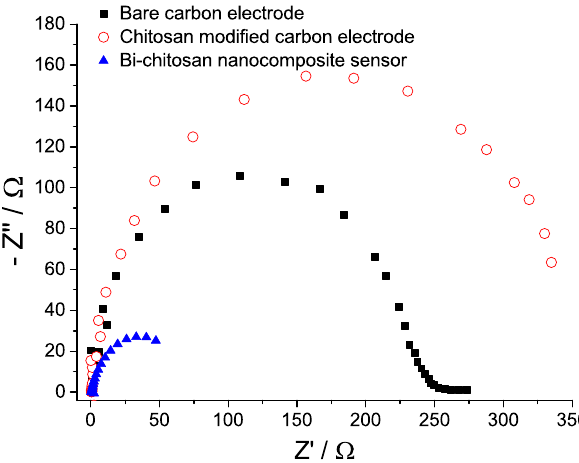
Figure 4. Nyquist diagrams of a bare carbon electrode, a chitosan modified carbon electrode, and a Bi-chitosan nanocomposite sensor. The impedance results were obtained using 10 mM potassium ferricyanide (K 3 (Fe(CN) 6 ]) as an electrolyte solution at a frequency range 10 mHz to 500